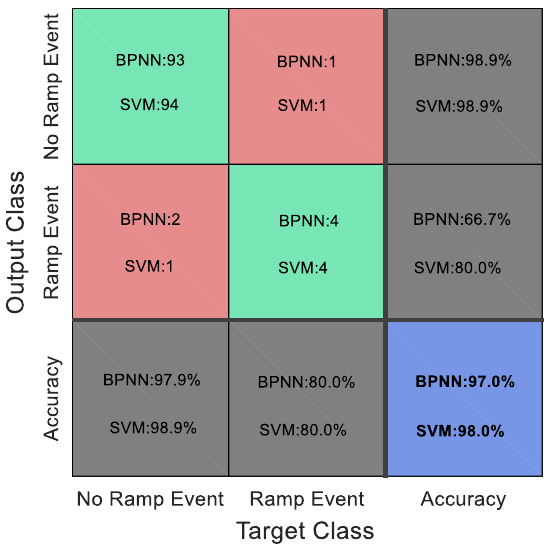
Figure 18. Confusion matrix of the prediction results in the No. 1 wind farm.